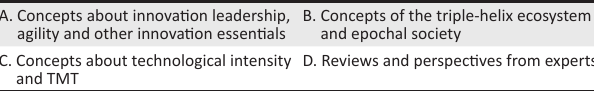
TABLE 1: Conceptual data used for this